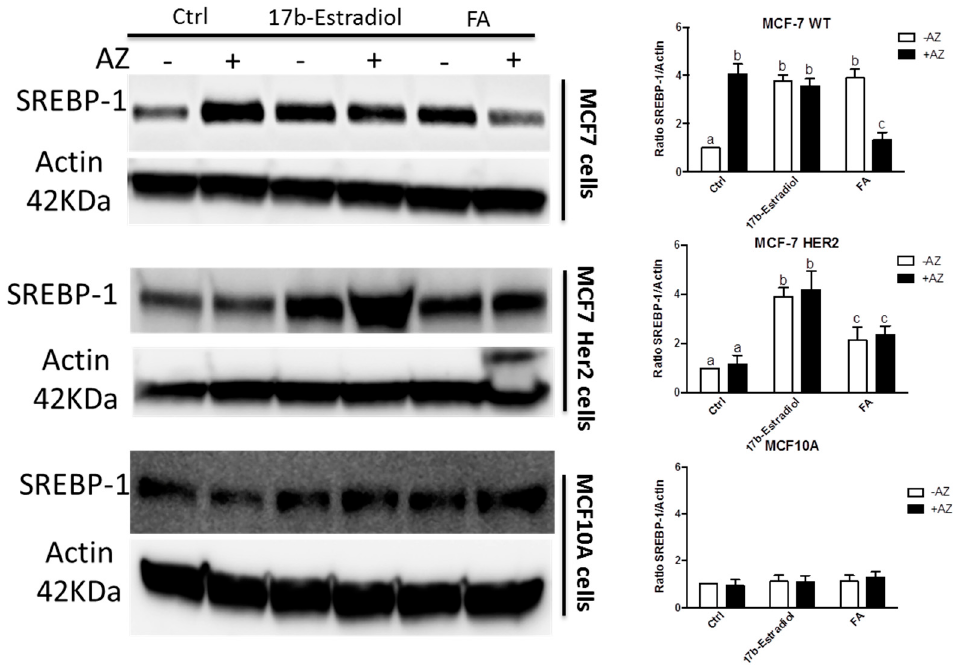
Figure 9. SREBP-1 expression profile in the 3 cell lines. Immunoblot analysis of SREBP-1 expression in MCF-7, T47D and MCF-10A cells incubated with 2 nM, 10 μ M and 100 μ M of 17 β -estradiol, ferulic Acid (FA) and acetazolamide (AZ), respectively, or with vehicle EtOH and DMSO (Ctrl). The graphs show densitometry quantification of the SREBP-1 blots in the 3 cell lines. Immunoblots are representative of 3 independent experiments. Data are means ± SEM, n = 3 independent experiments. Values that have a different superscript are significantly different ( p < 0.05) as determined by one-way ANOVA test with subsequent Tukey’s post hoc test.